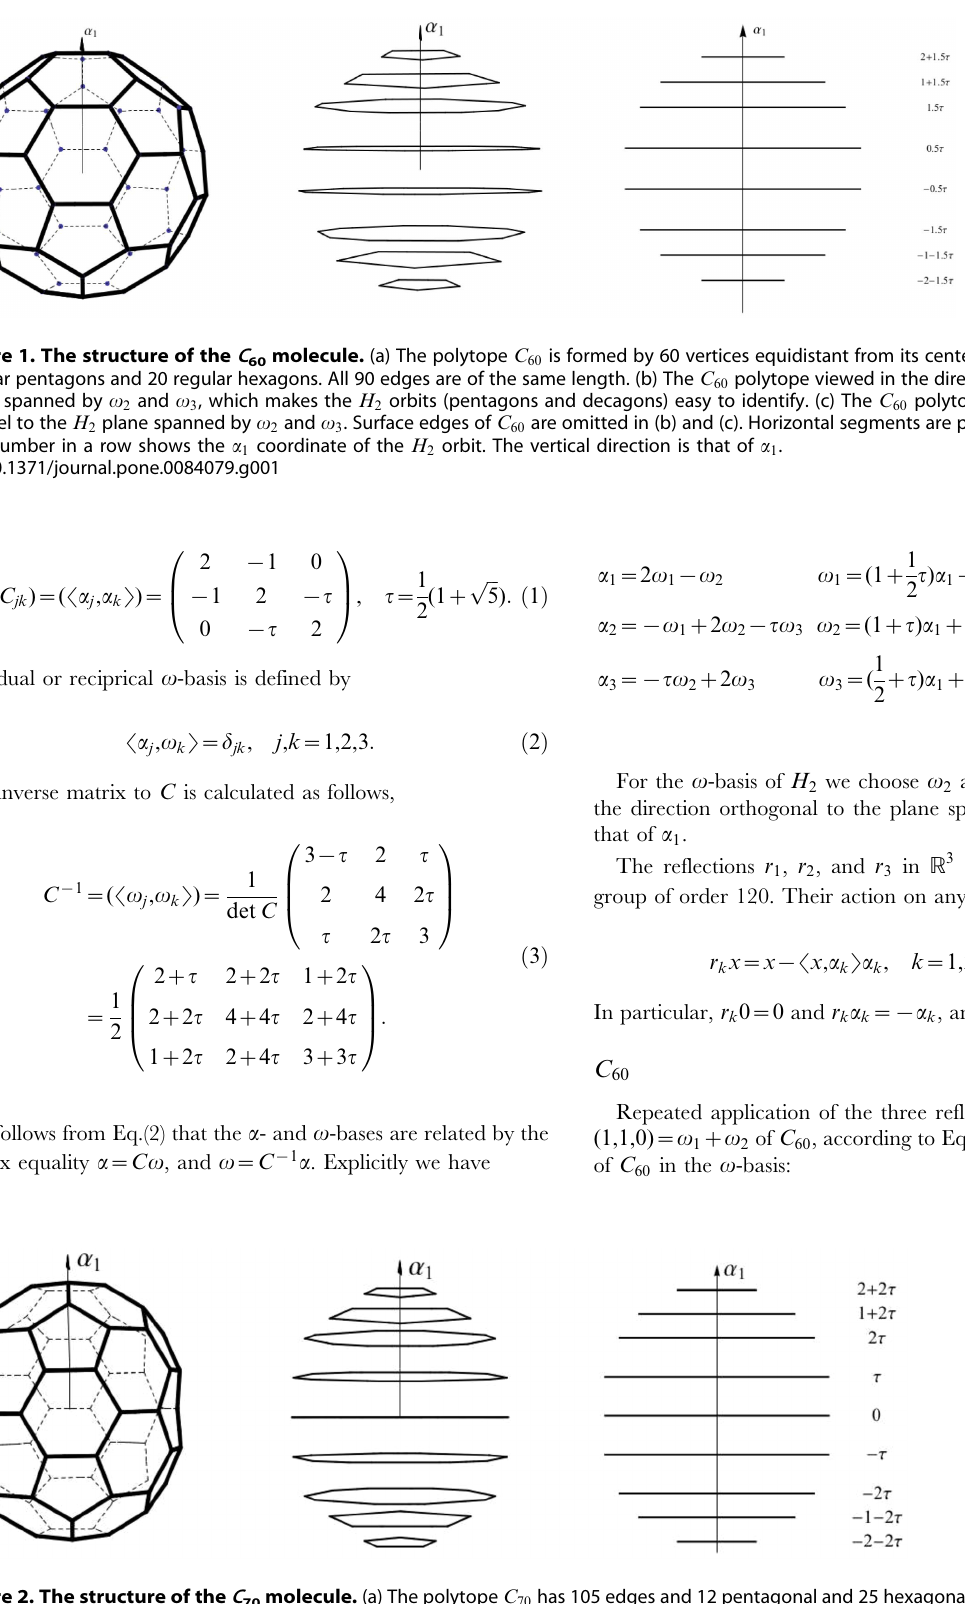
Figure 2. The structure of the C 70 molecule. (a) The polytope C 70 has 105 edges and 12 pentagonal and 25 hexagonal faces. (b) C 70 viewed from a direction almost parallel to the plane of v 2 and v 3 . (c) The H 2 structure of C 70 viewed from a direction parallel to the plane of v 2 and v 3 . The column of numbers shows the a 1 -coordinate of the H 2 orbits of vertices of C 70 . The inserted decagon has the a 1 -coordinate equal to 0. Surface edges are omitted in (b) and (c).